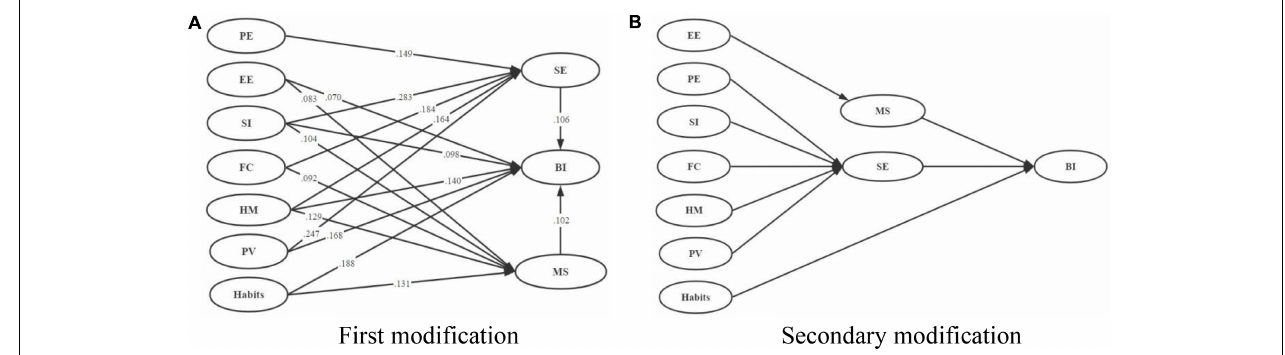
FIGURE 4 | Modification of the UTAUT2-based e-learning model. (A) First modification. (B) Secondary